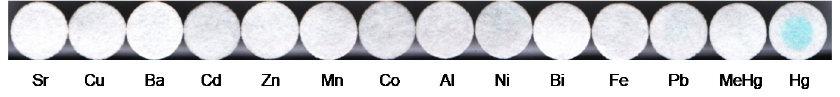
Figure 6. Selectivity of the method toward heavy metal ions.